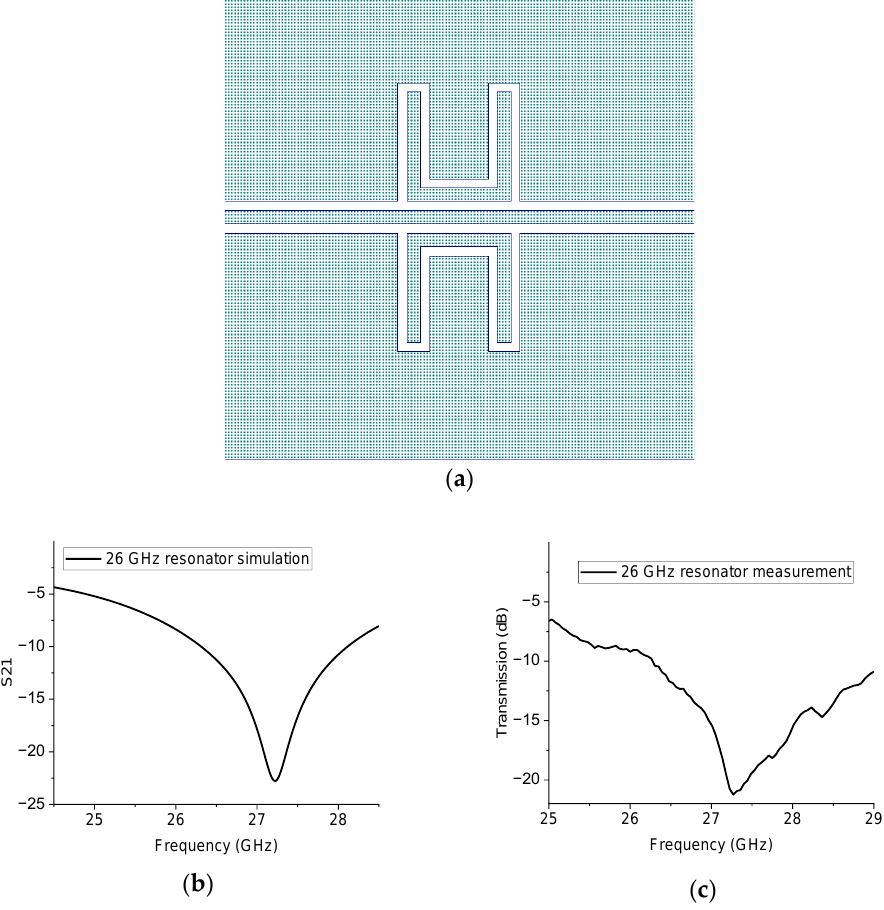
Figure 12. Symmetric 26 GHz resonator layout ( a ), theoretical expectation ( b ), and experimental measurement ( c ).